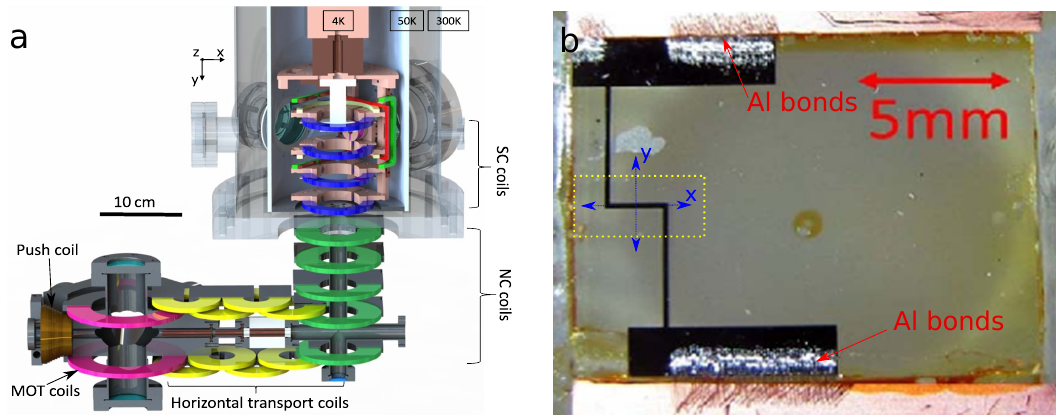
Figure 1: (a), sketch of the experimental setup adapted from [ 37 ] . A magnetic con- veyor belt transport which brings ultracold atoms to a cryogenic environment. Its components are: Push coil (brown), MOT coils (pink), horizontal transport coils (yellow), normal conducting vertical transport coils (green) and superconducting transport coils (blue). (b), a niobium atomchip on a sapphire substrate. The central region of the Z-wire, roughly defined by the yellow dashed box, indicates the region where the remanent magnetization remains even after exceeding I the critical current in our setup. See section